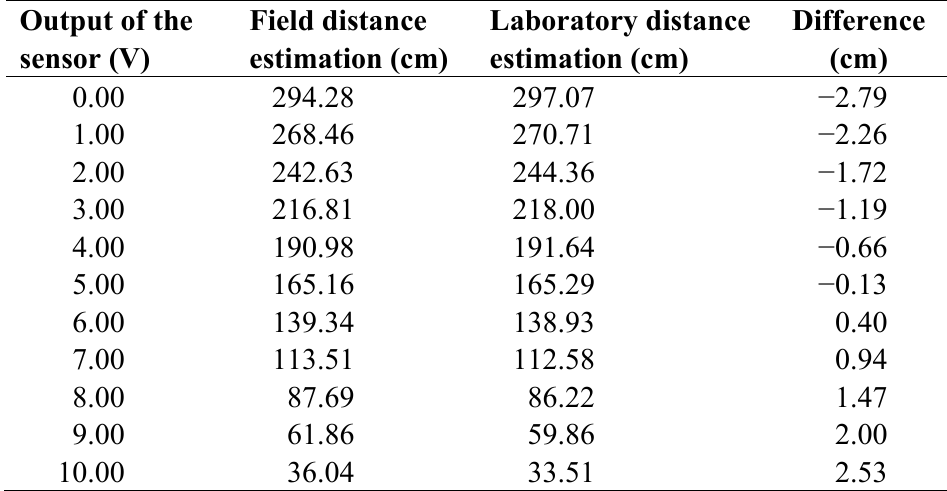
Table 5. Numerical simulation comparing distance estimations according to field and laboratory